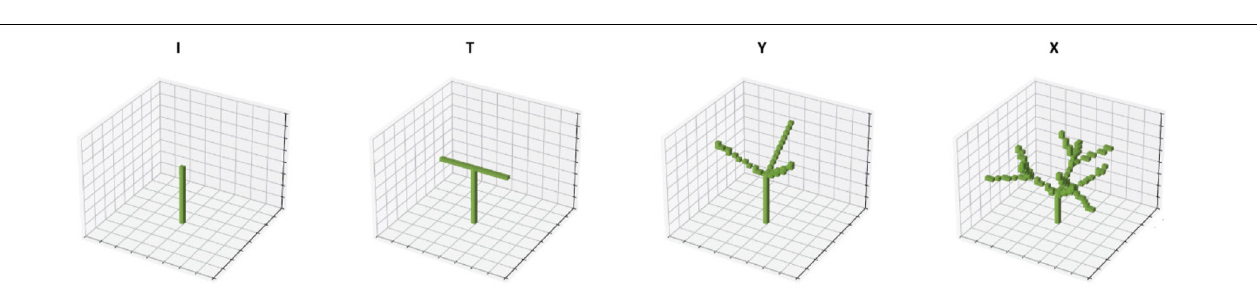
voxel grid. We set the size of the grid to be 32 × 32 × 32, due to hardware constraints, and assign each location of the grid